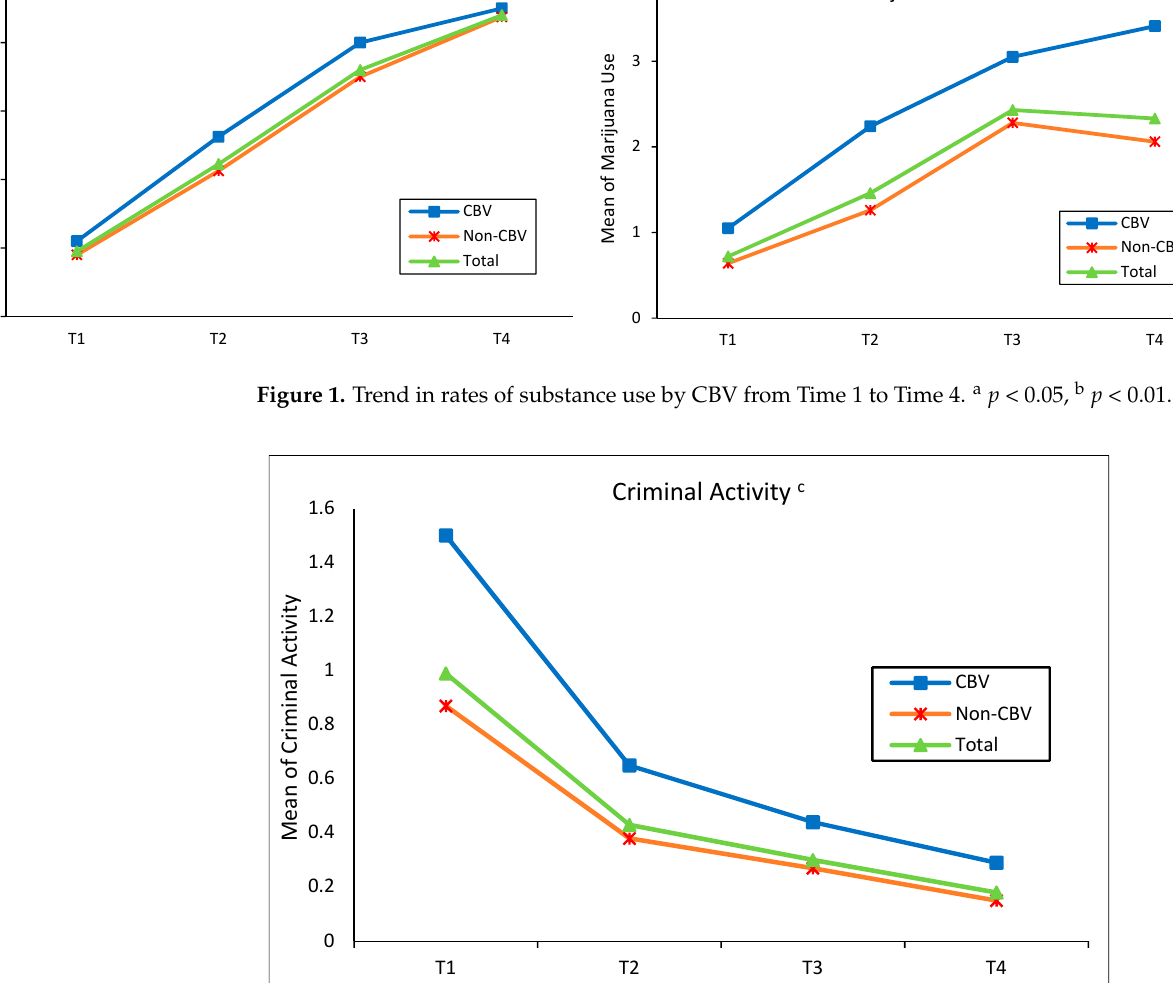
Figure 2. Trend in rates of criminal activity by CBV from Time 1 to Time 4. c p < 0.001. To examine whether changes in substance use and criminal activity over time differ for two groups (CBV and non-CBV), the moderation analyses were performed with the two-way interaction term (time×CBV). Additionally, the gender differences in the moder- ating effects were investigated. Table 5 presents the changes of the parameter estimates in substance use and criminal activity over time by CBV for the total, male and female groups. The slope changes in cigarette use, marijuana use, and criminal activity over time differed significantly between bullied youths and non-bullied youths. Compared with non-bullied youths, bullied youths reported the faster slope changes in the levels of ciga- rette use (ERR = 1.46, p < 0.01) and marijuana use (ERR = 1.52, p < 0.05) and the level of criminal activity (ERR = 1.15, p < 0.01). The slope changes in the level of criminal activity between CBV and non-CBV over time were significant for both male and female groups. However, the slope changes in level of cigarette use by CBV over time were significant only for males but not females, while those in level of marijuana use by CBV over time were significant only for females but not males.